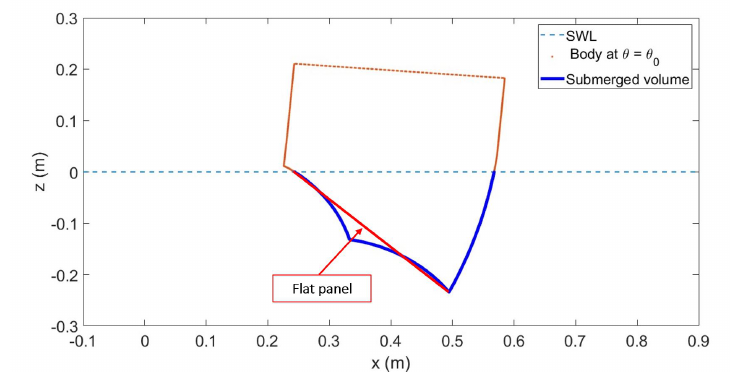
Figure 4. Geometry used to calculate the approximate quadratic drag